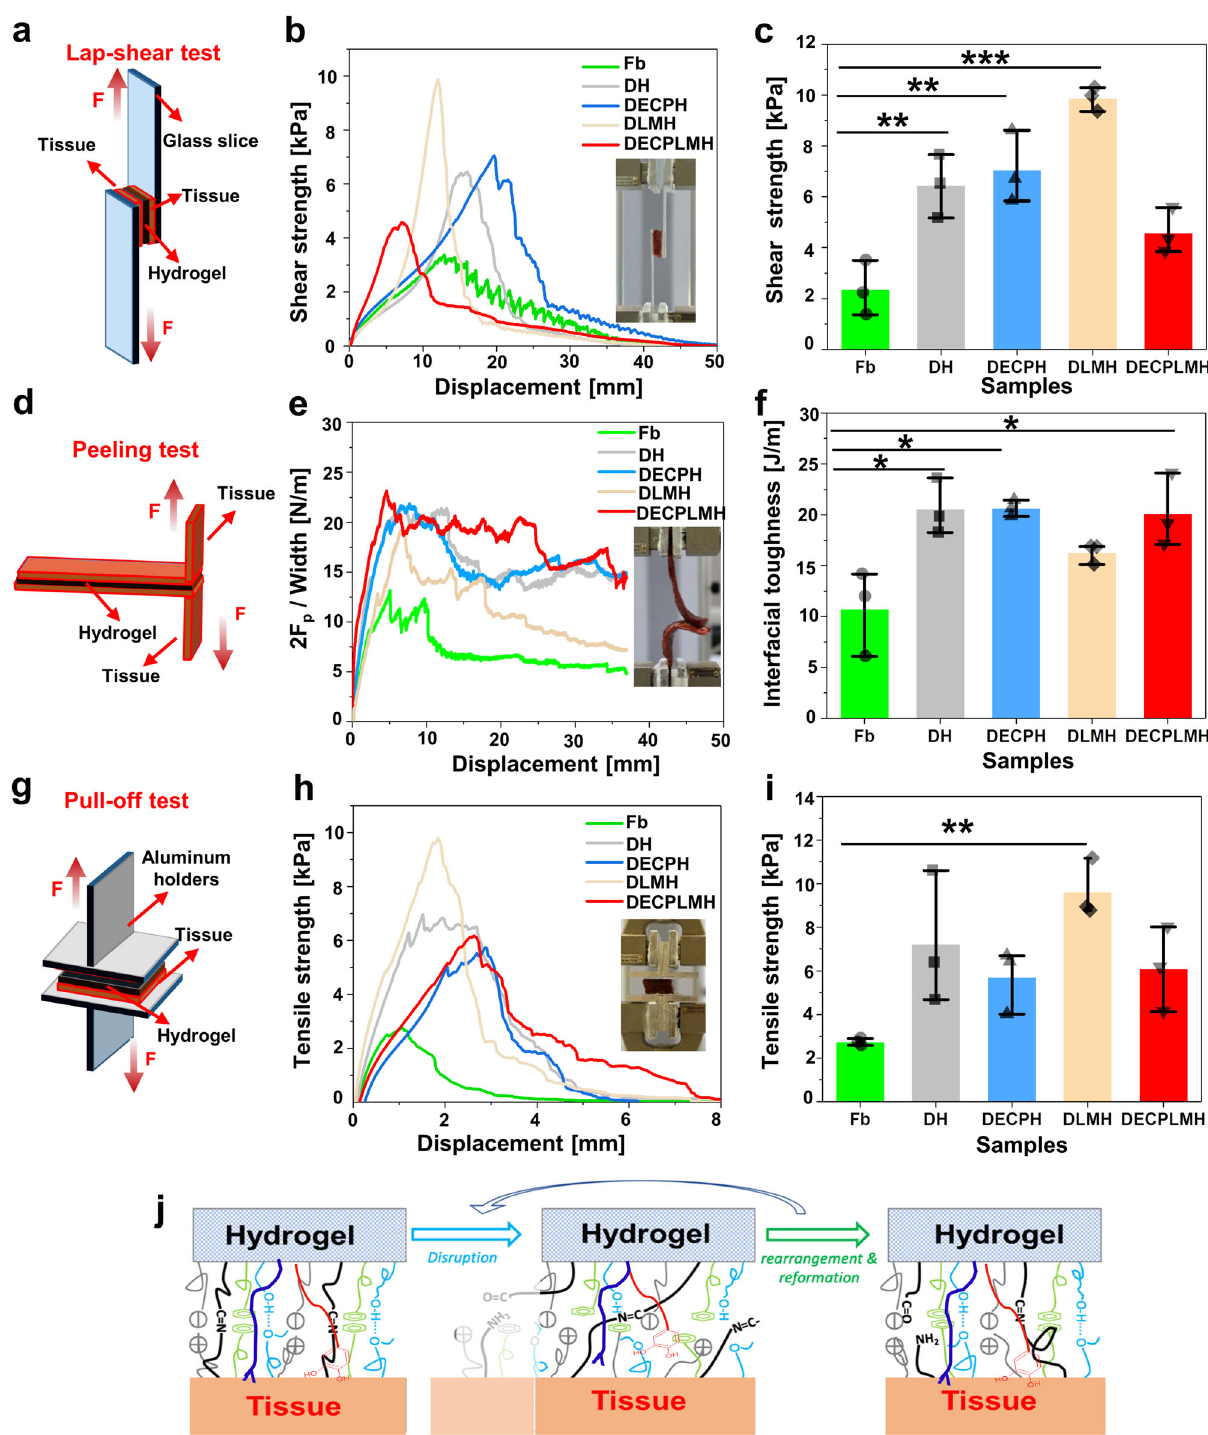
of the non-electroconductive DH hydrogel (Fig. 6e). The con- ductivity of DECPLMH hydrogel was higher than that of the DECPH hydrogel and DLMH when the same corresponding concentrations of P CP or P LM were used (Fig. 6f). The electro- conductivity measurements were further performed with varied concentrations of LM in DECPLMH. As shown in Supplementary Fig. 15, the corresponding increase of conductivity can be achieved when increasing LM from 0.1 to 5% (W/V).